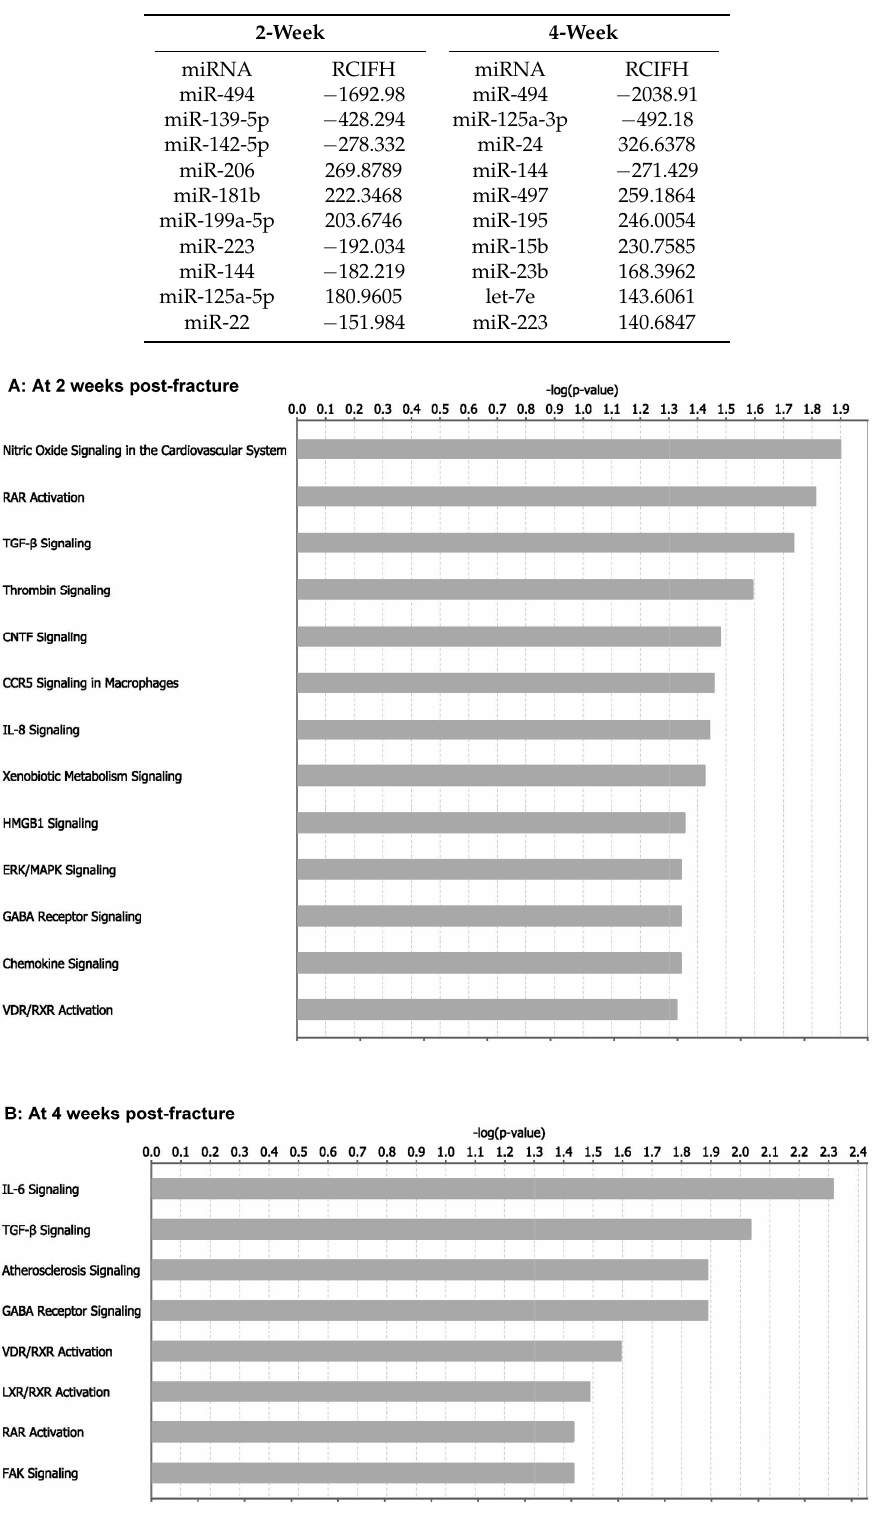
Figure 4. Significantly enriched pathways of top 100 highest miRNA contribution to impaired fracture healing (RCIFH) miRNA targets at ( A ) 2-week after fracture and ( B ) 4-week after fracture.